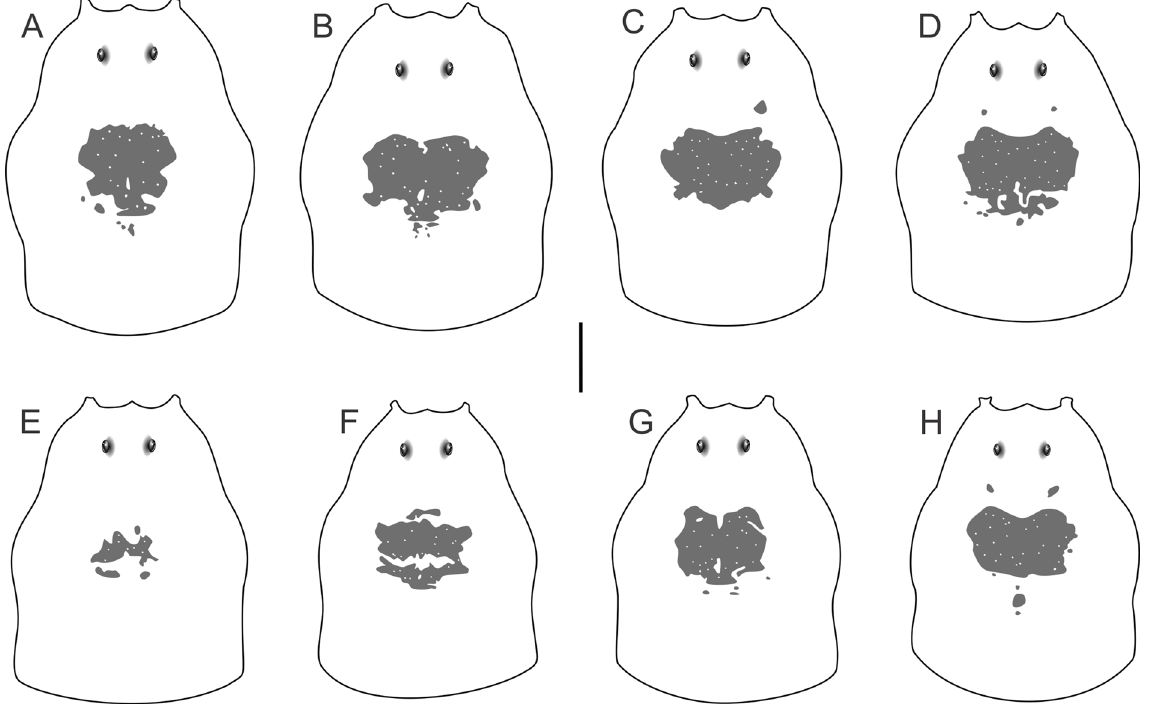
Fig. 6. Libitia cordata (Gervais, 1844), variation of spot pattern on dorsal scutum. A–D . ♂♂. A . ICN-AO 1040. B . ICN-AO 421. C . ICN-AO 1040. D . ICN-AO 1040. E–H . ♀♀. E–F . ICN-AO